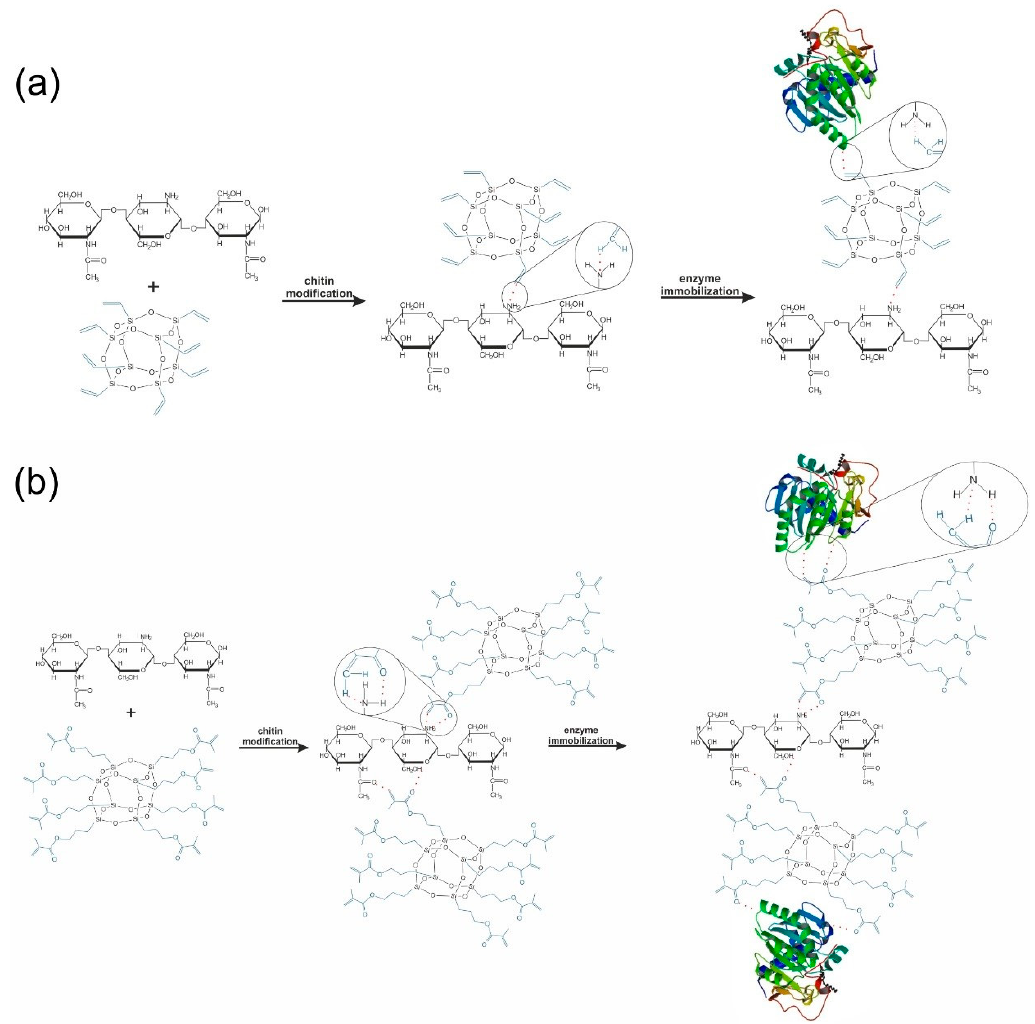
Figure 6. Proposed mechanism for the formation of: ( a ) chitin + VPOSS + CALB; and ( b ) chitin + MPOSS + CALB systems. Hydrogen bonds are marked by red dotted line.